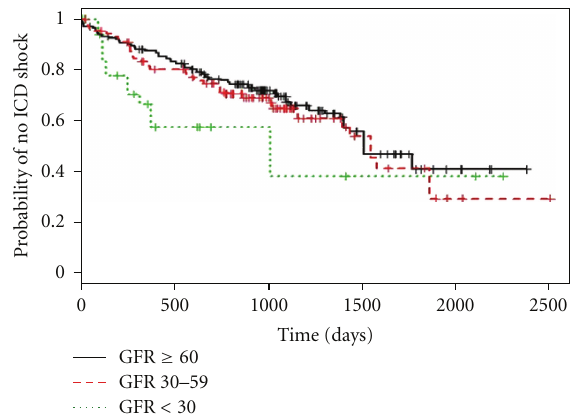
Figure 1: Kaplan-Meier curves for time to first appropriate ICD shock based on GFR. The “+” sign in the graph indicates